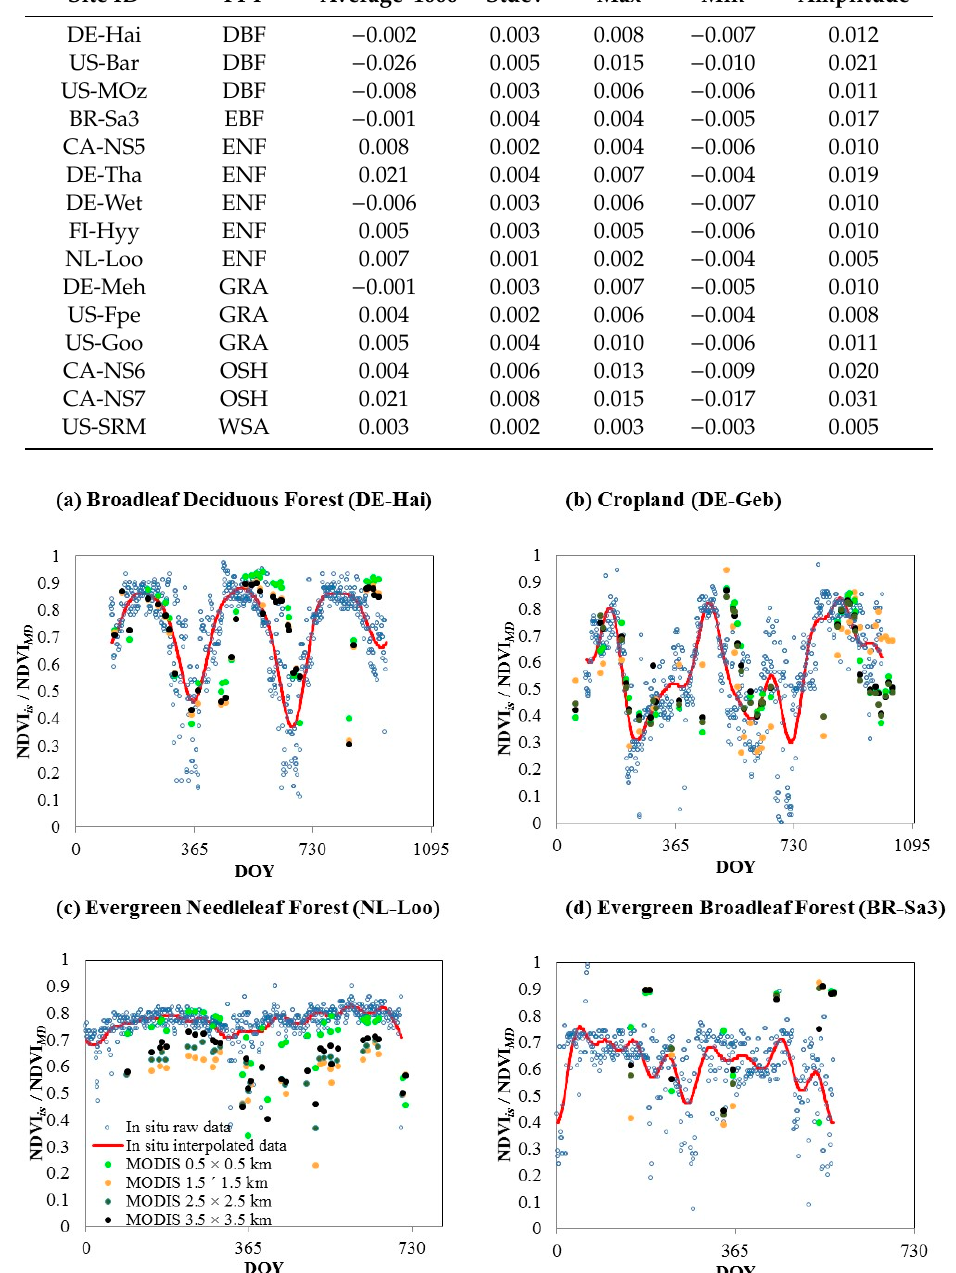
Figure 4. Example output of in situ Fourier series model fitted to NDVI (NDVI is ) time series data of: ( a ) a deciduous broadleaf forest (BDF); ( b ) a cropland (CRO); ( c ) an evergreen needle leaf forest (ENF); and ( d ) an evergreen broadleaf forest (EBF). Blue circles represent raw NDVI is data and red lines represent Fourier series fitted NDVI is data. Filled dots represent MODIS NDVI time series at different spatial resolutions (0.5 × 0.5 km: Green; 1.5 × 1.5 km: Orange; 2.5 × 2.5 km: Dark green; and 3.5 × 3.5 km: Black).